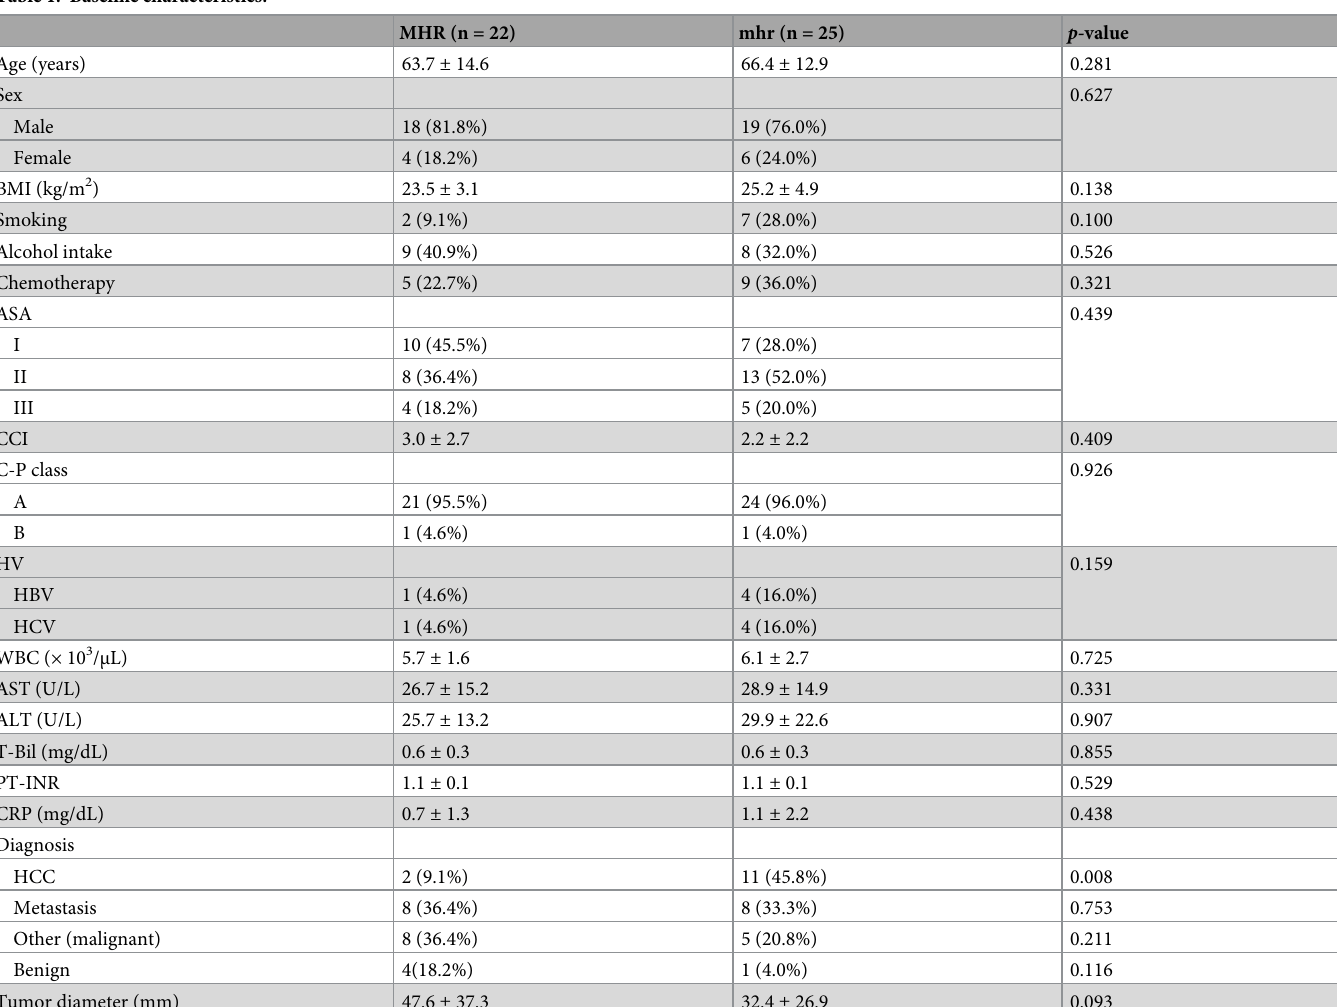
Table 1. Baseline